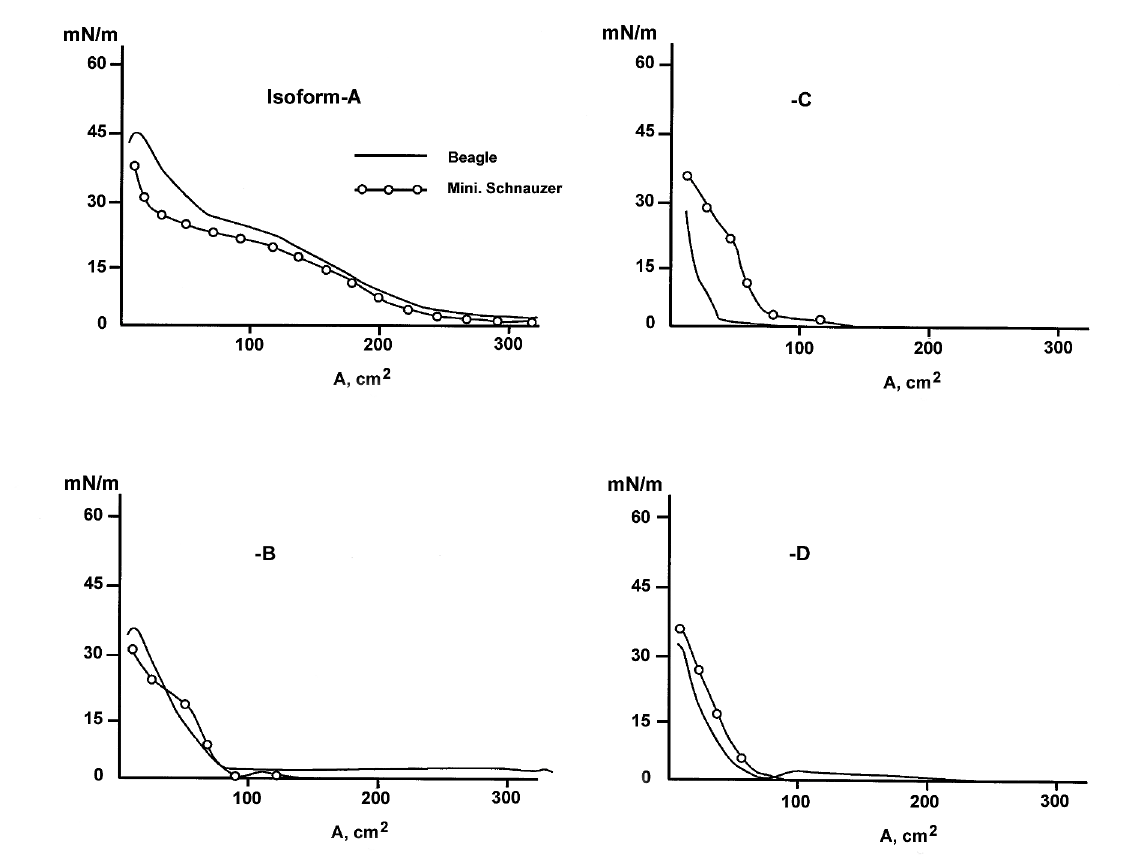
Figure 1 – A force area curve of isolated isoforms at the air-water interface measured by Laud film balance. Experimental details are described in Materials and Methods